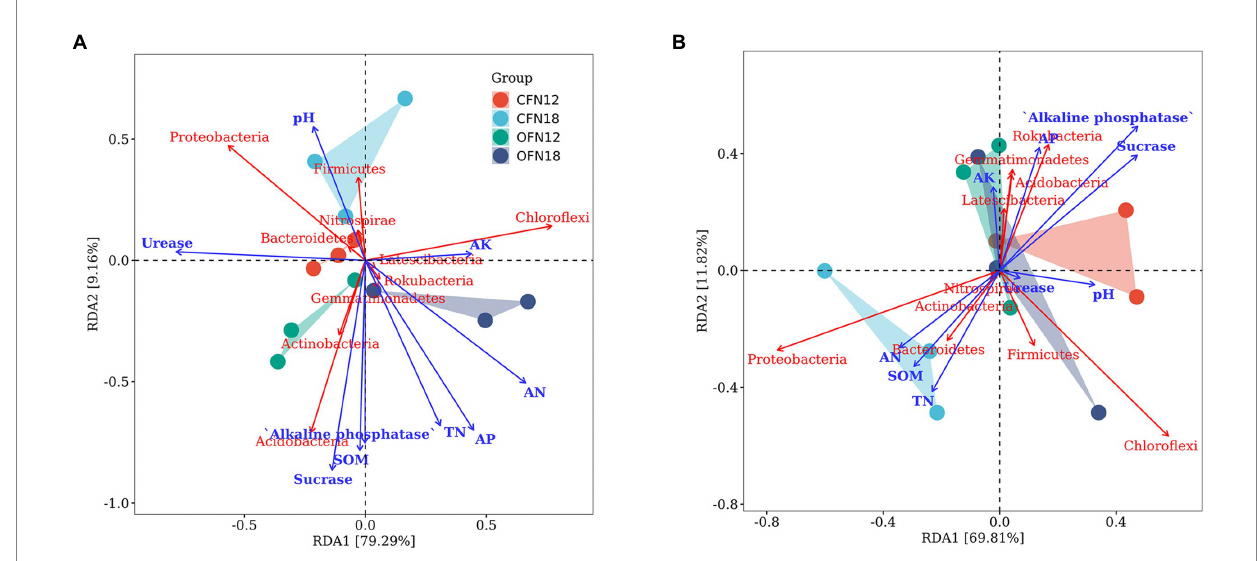
FIGURE 9 Redundancy analysis of soil nutrients, enzyme activities and abundant phyla. (A) 0–10 cm; (B) 10–20